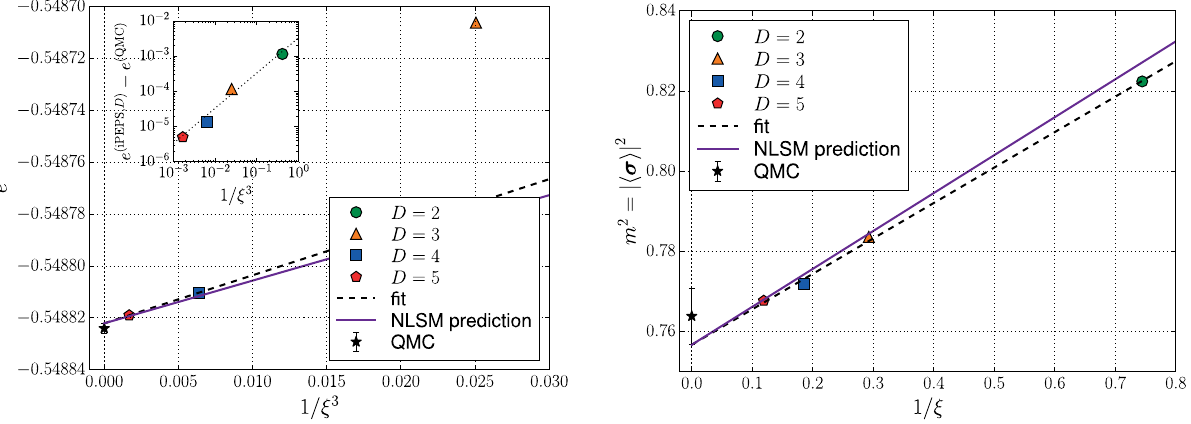
FIG. 7. S ¼ 1 = 2 XY ferromagnet: iPEPS data for the ground-state energy per site e (left-hand panel) and the order parameter squared m 2 (right-hand panel). We plot the data as a function of the expected 1 = ξ 3 (for e ) and 1 = ξ (for m 2 ) dependence. The linear fits to the D ¼ 4 , 5 results in the left-hand and all D ≥ 2 in the right-hand panel extrapolate reasonably closely to the quantum Monte Carlo results [68], and may well be more accurate than the somewhat antiquated QMC results. The inset in the left-hand panel highlights the overall 1 = ξ 3 convergence of the energy per site. In both panels we include a prediction based on the conjectured finite ξ formulas for the nonlinear sigma model (NLSM), cf. Eqs. (22) and (23) and the main